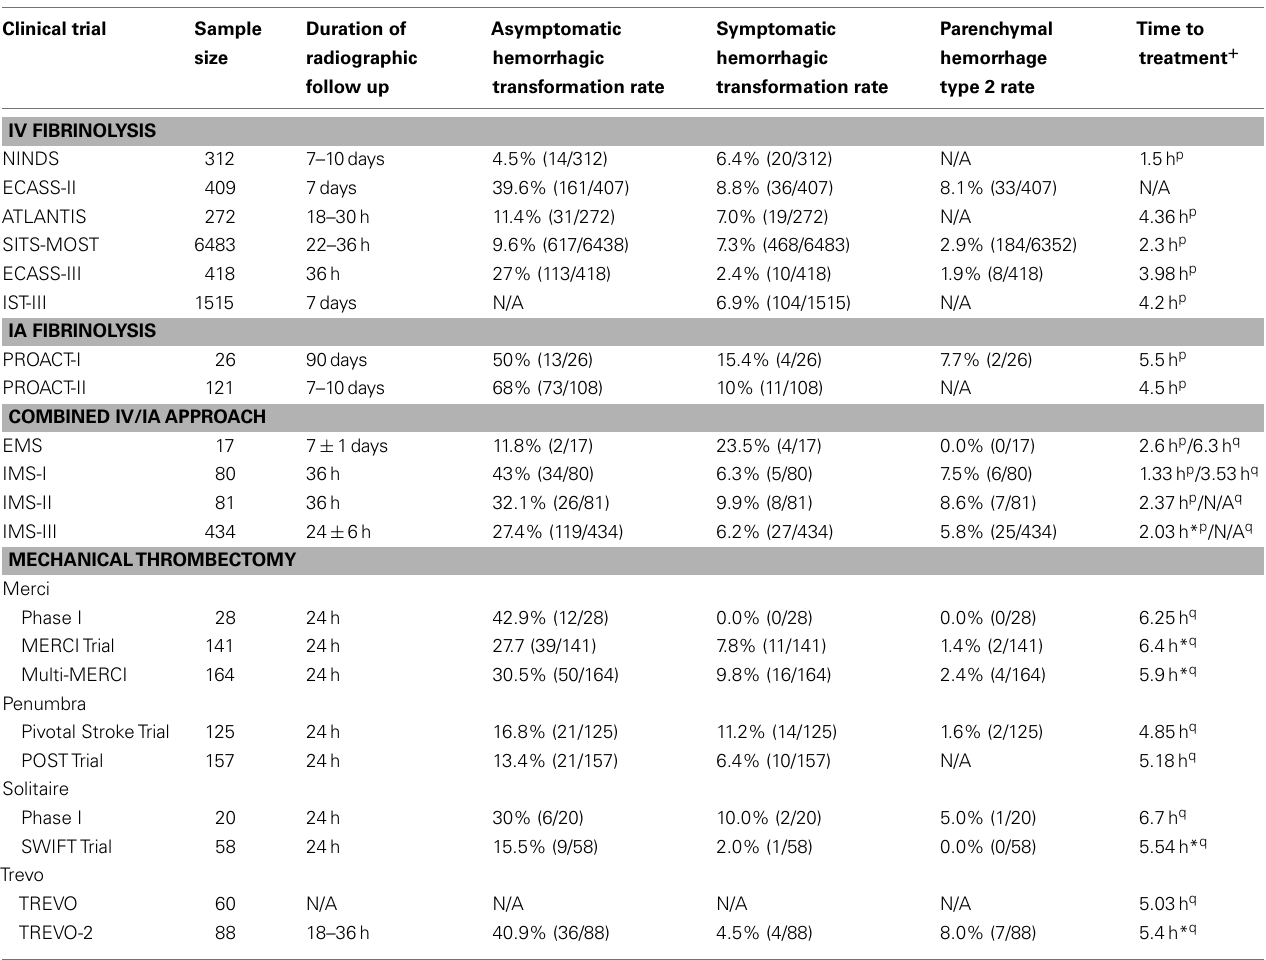
Table 2 | Summary of hemorrhagic transformation data from major clinical trials ofAIS